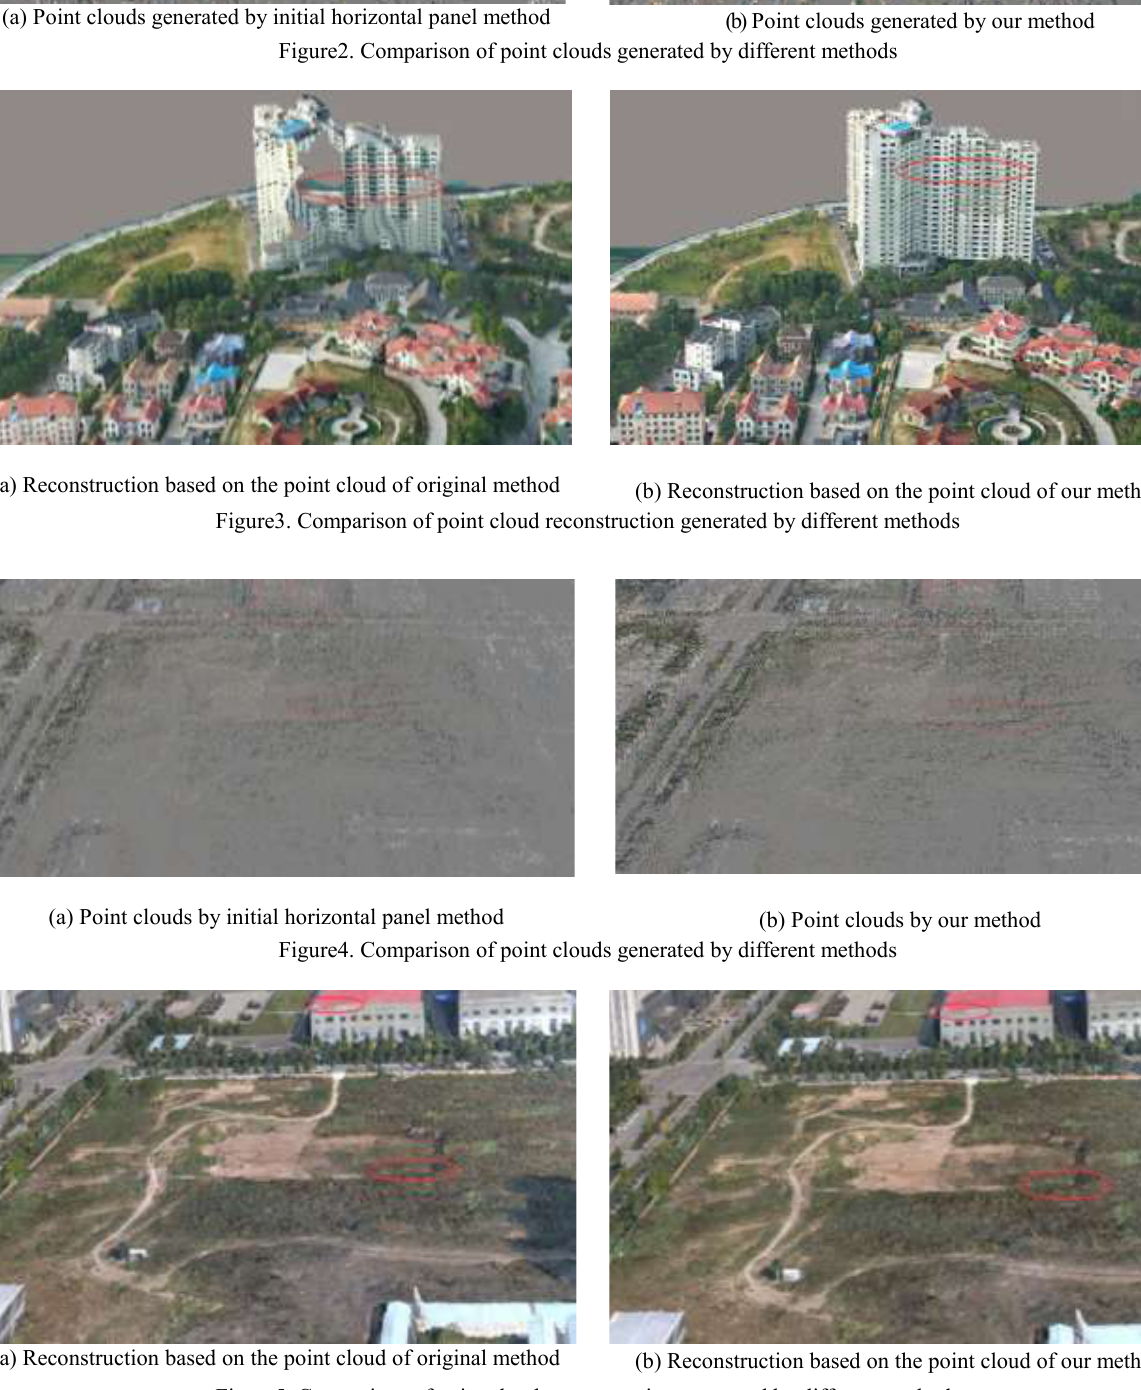
Figure5. Comparison of point cloud reconstruction generated by different